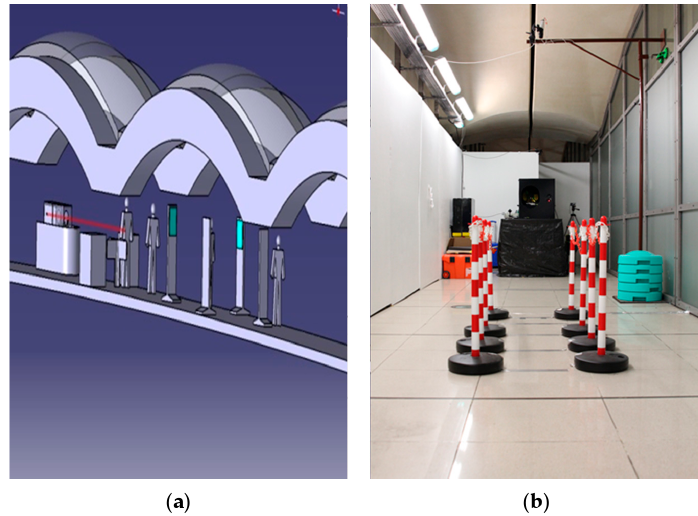
Figure 10. RADEX, and gate with sensors, 3D-model ( a ) and set-up ( b ) during the trials in the